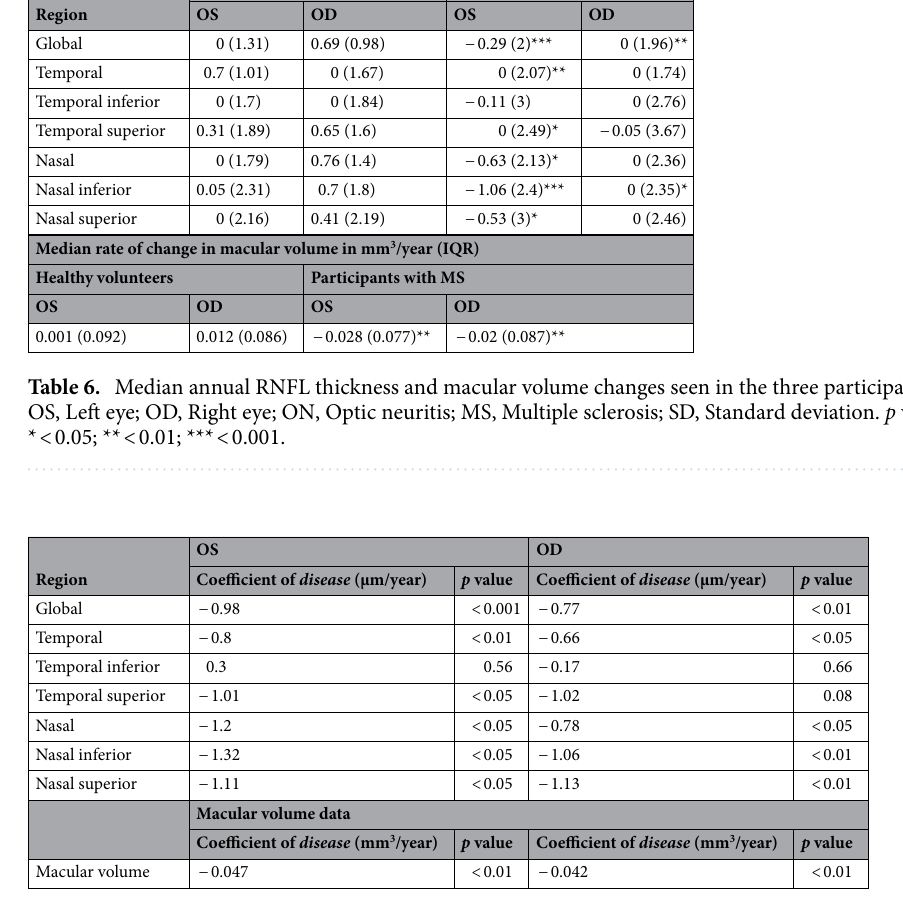
Table 7. Coefficient values produced when modelling RNFL thickness and macular volume data produced from follow-up analysis. OS, Left eye; OD, Right eye.